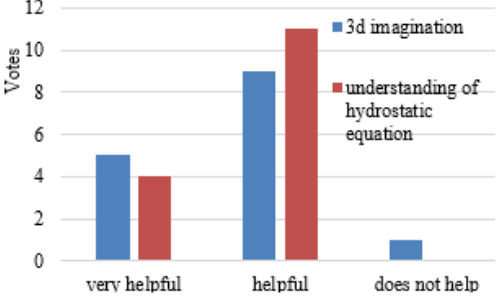
Fig. 7. Result of query (single choice) about the benefit in using VR for the 3d imagination (blue) and for the understanding derivation of the hydrostatic base equation (red)